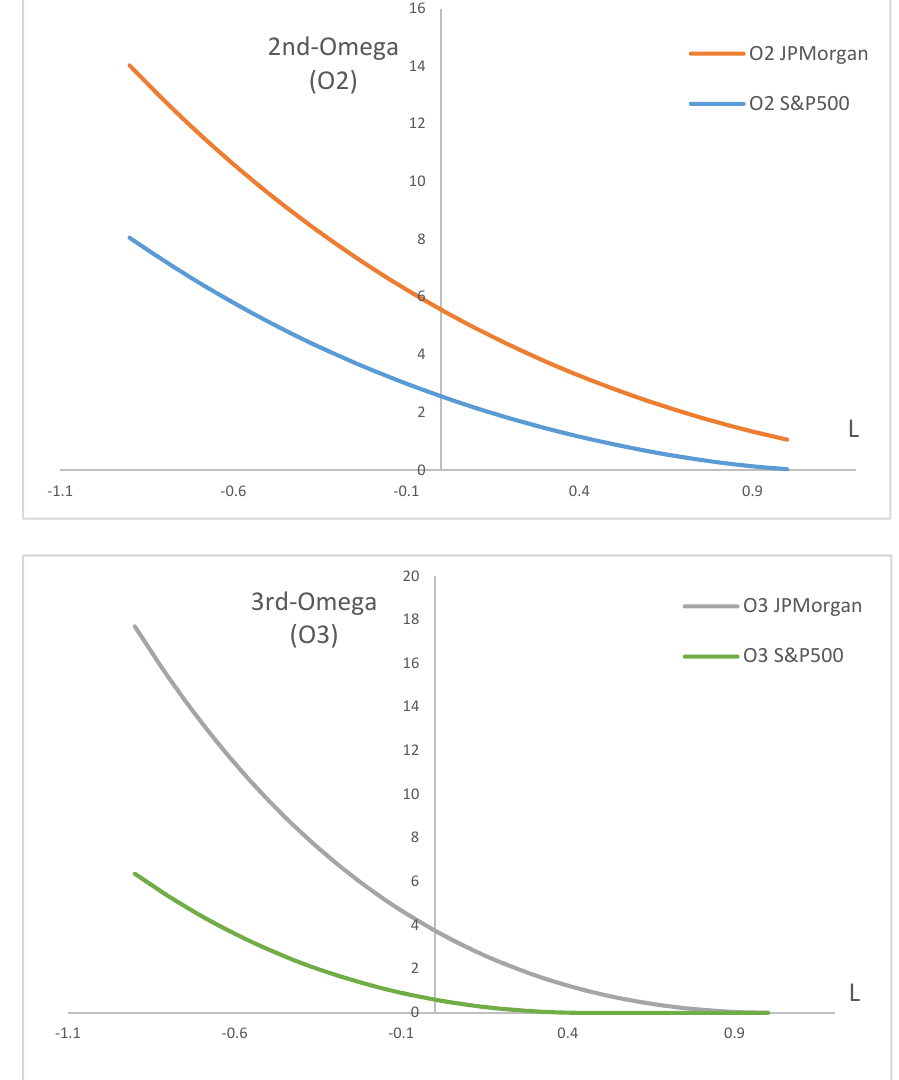
Figure 2. 1st-, 2nd-,3rd-order Omega as a monotone function of return threshold.